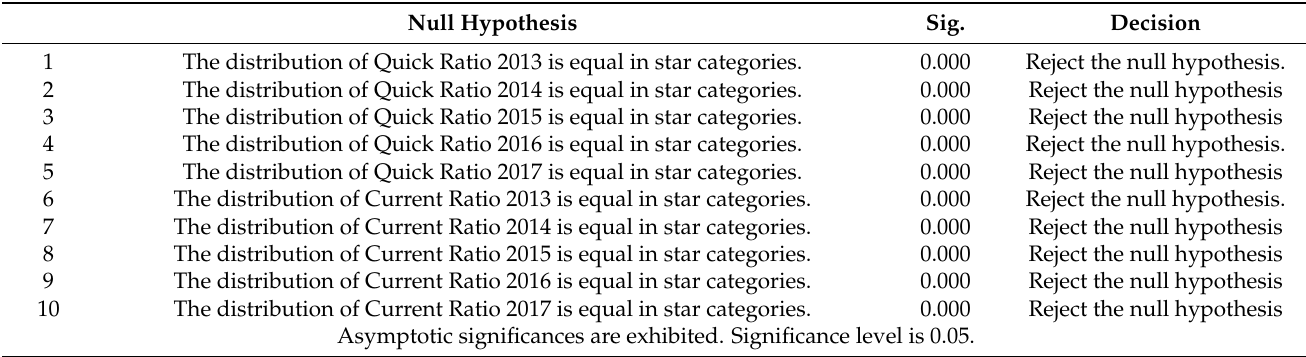
Figure 6. Quick Ratio, with and without a restaurant. The STAR variable is very important in the hospitality sector, influencing several ratios. Then through the test, it was analyzed whether the liquidity ratios vary according to the classification of the hotels in official star terms (Table 11). Table 11. Results of non-parametric Kruskal–Wallis test to verify if STAR presents equal distribution. Null Hypothesis Sig. Decision